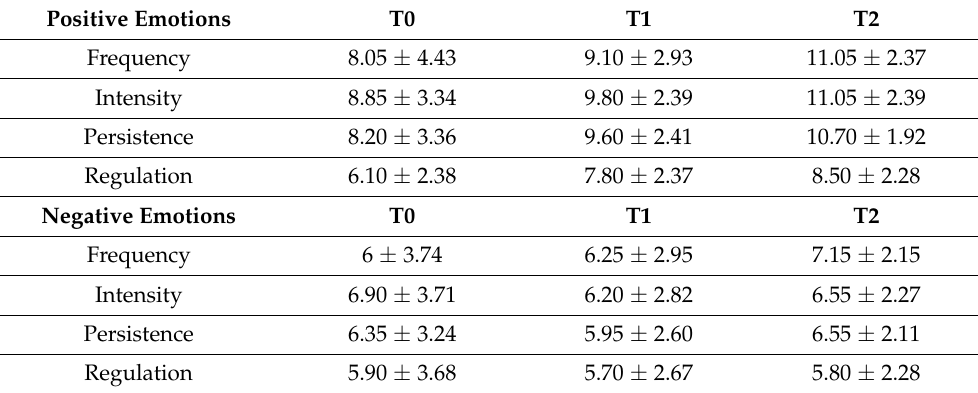
Table 3. Means and standard deviations of the MEQ in different times of